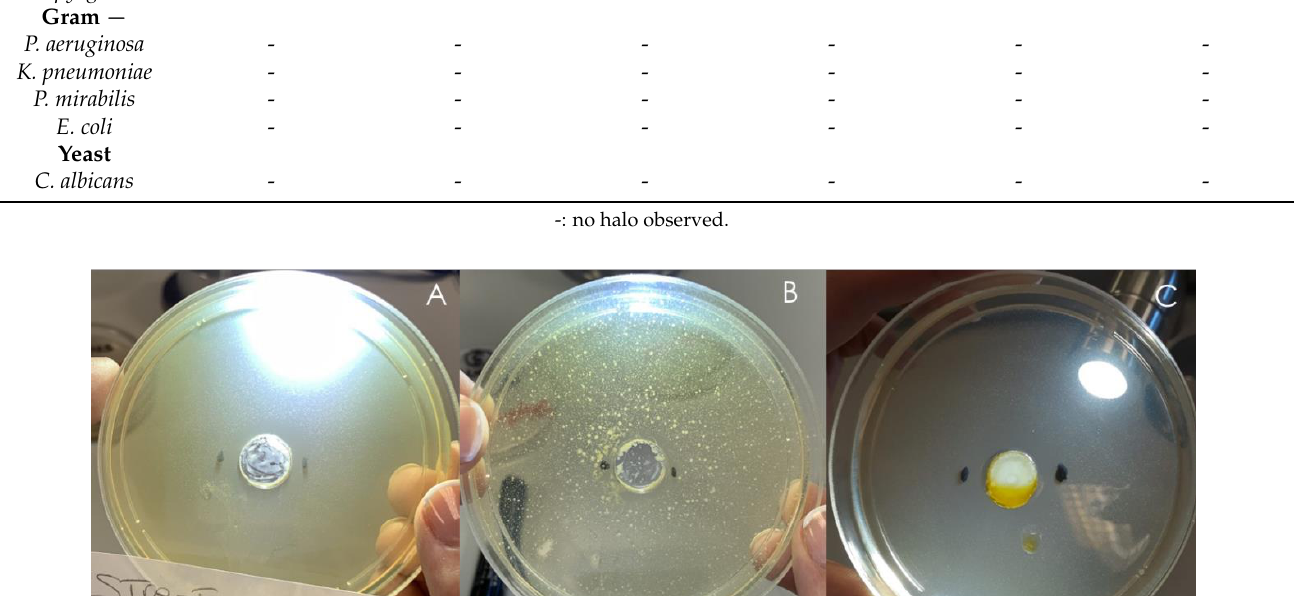
Figure 6. MTT assay on RAW 264.7 cells treated with different D.E. concentrations and incubated for 24 h. RAW 264.7 cells co-treated with lipopolysaccharide (LPS) was used as Control, n = 6 ± SD. Dotted lines indicate 100% and 6%, respectively. *** p < 0.0001, D.E. vs. Control (One-way ANOVA test). Based on the cytotoxicity results, the anti-inflammatory effect of D.E. in LPS-treated RAW 264.7 cell line was investigated in the concentrations range of 0.019–0.315 mg/mL. The incubation of LPS-stimulated RAW 264.7 with D.E. for 24 h induced a significant de- crease of NO release in the concentration range of 0.075–0.300 mg/mL (Figure 7A). The obtained concentration curve provided an IC 50 = 0.136 ± 0.009 mg/mL for the downregu- lation of NO release by D.E. (Figure 7B).